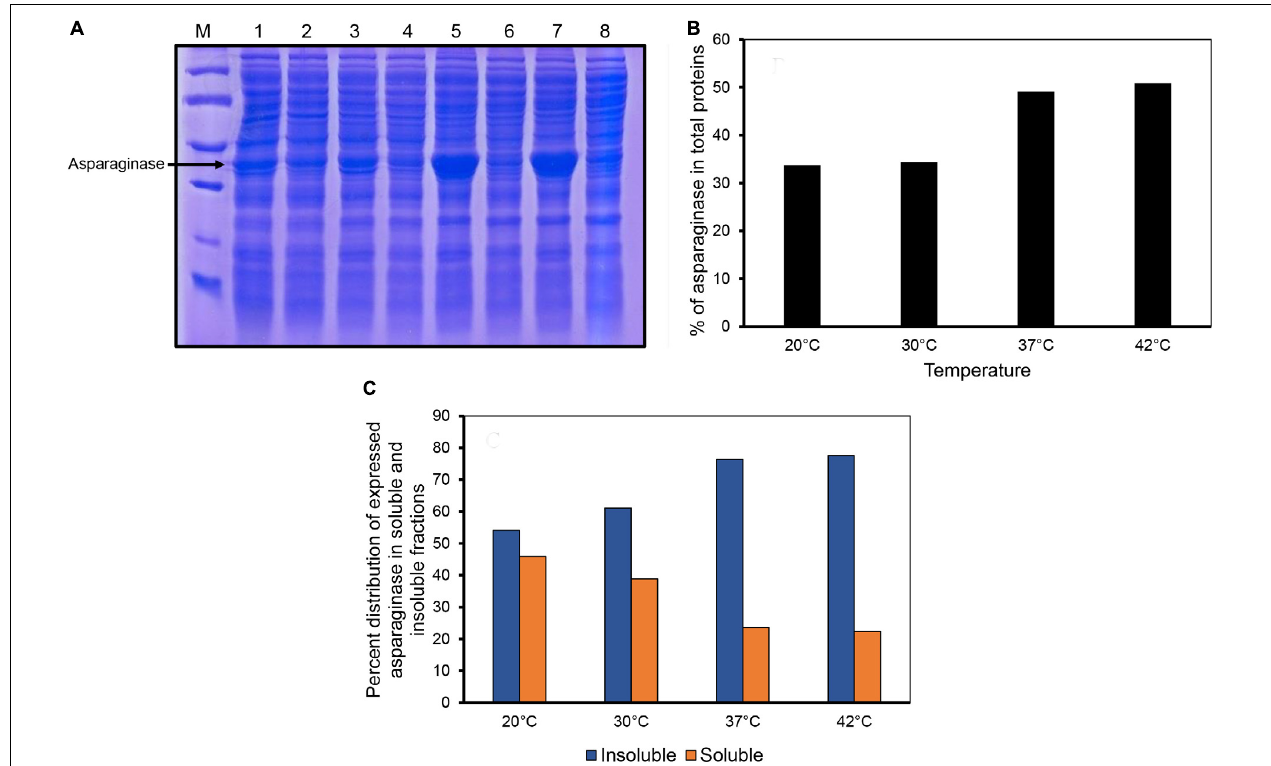
FIGURE 1 | Expression of asparaginase at different induction temperatures. (A) SDS-PAGE analysis of solubility profiles of asparaginase expressed at different induction temperatures. Lane M, molecular weight markers (97, 66, 45, 30, and 20.1 kDa). Lanes 1, 3, 5, and 7 are insoluble fractions obtained at 20, 30, 37, and 42 ◦ C, respectively. Lanes 2, 4, 6, and 8 are the soluble fractions obtained at 20, 30, 37, and 42 ◦ C, respectively. (B) Percentage of expressed asparaginase with respect to the total cellular proteins. (C) Distribution of expressed asparaginase into soluble and insoluble (inclusion bodies)